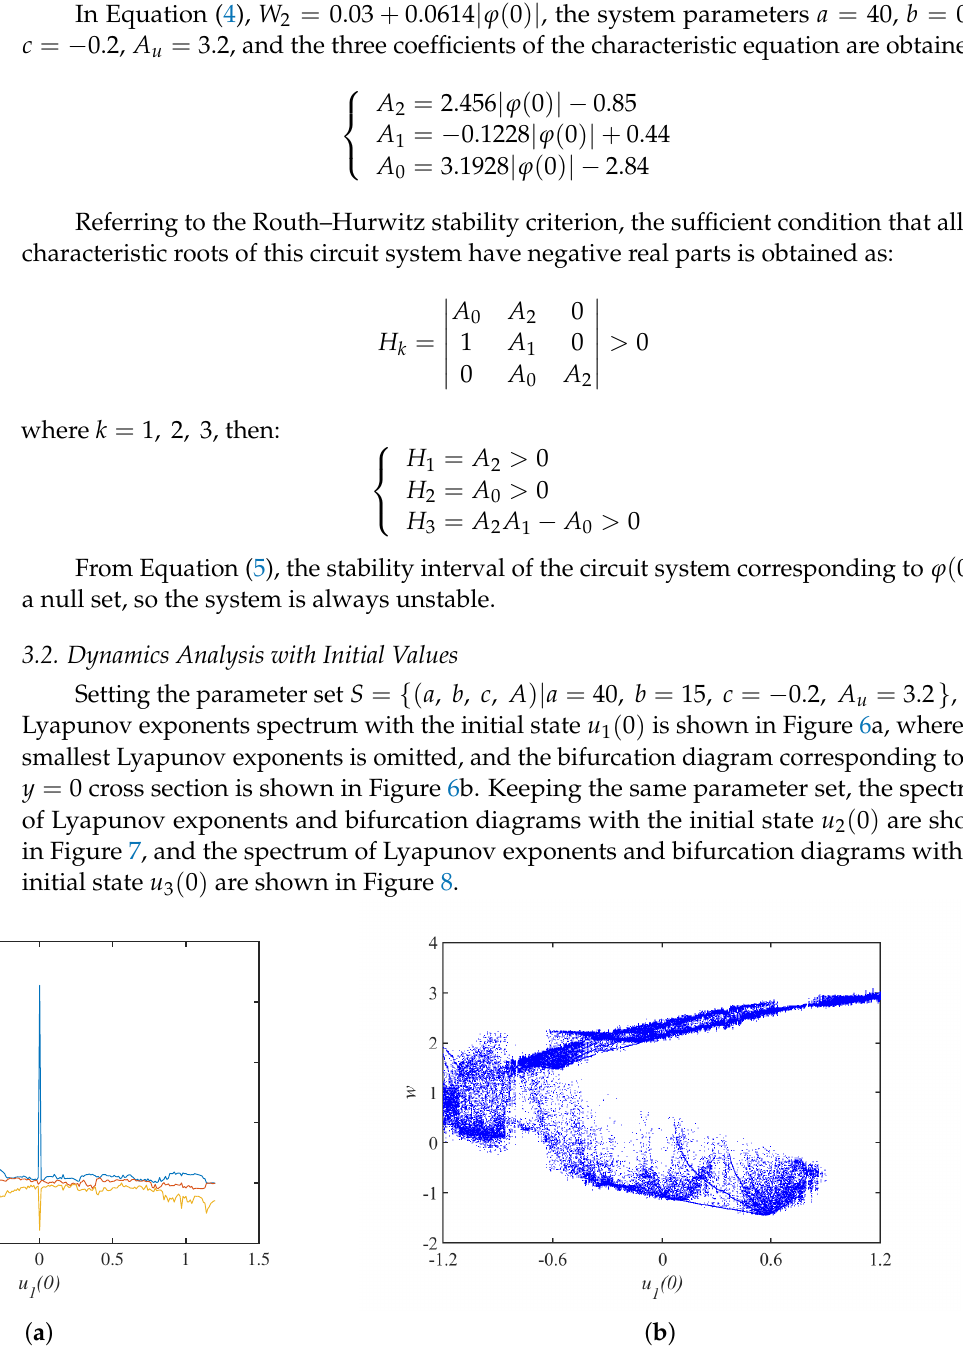
Figure 6. Dynamics analysis under the initial state u 1 ( 0 ) : ( a ) Lyapunov exponents spectrum; ( b ) bifurcation